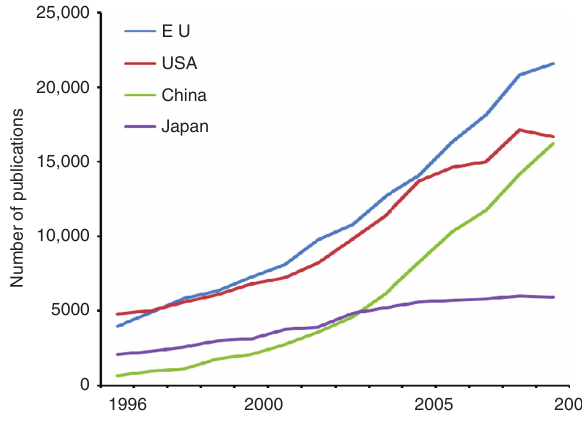
Figure 6 Schematic representation of the number of scientific publications in major countries.